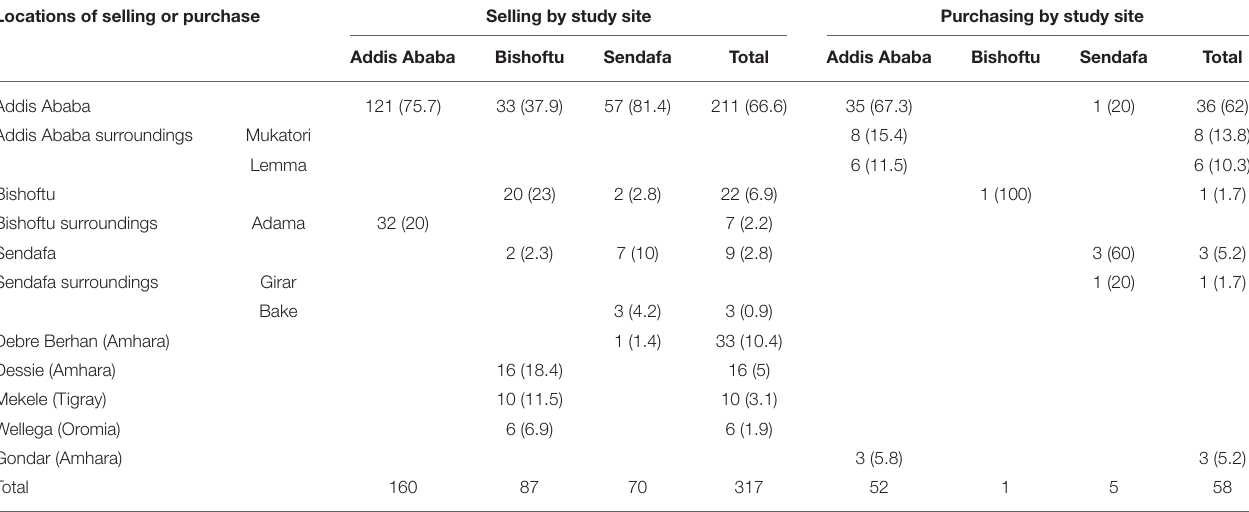
TABLE 5 | Purchase and selling locations of animals observed in the three study sites. Locations of selling or